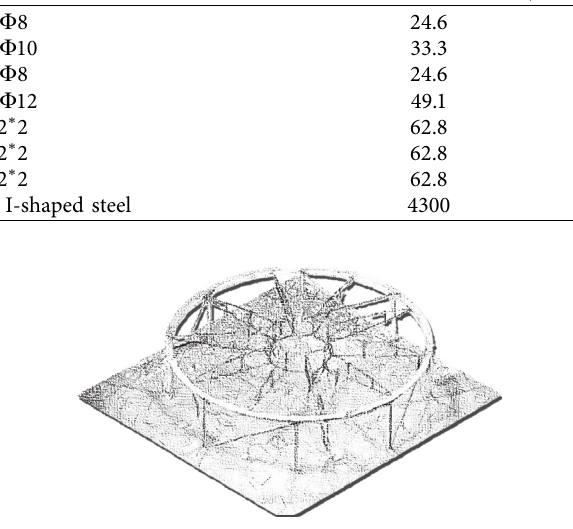
Figure 6: Point cloud model after